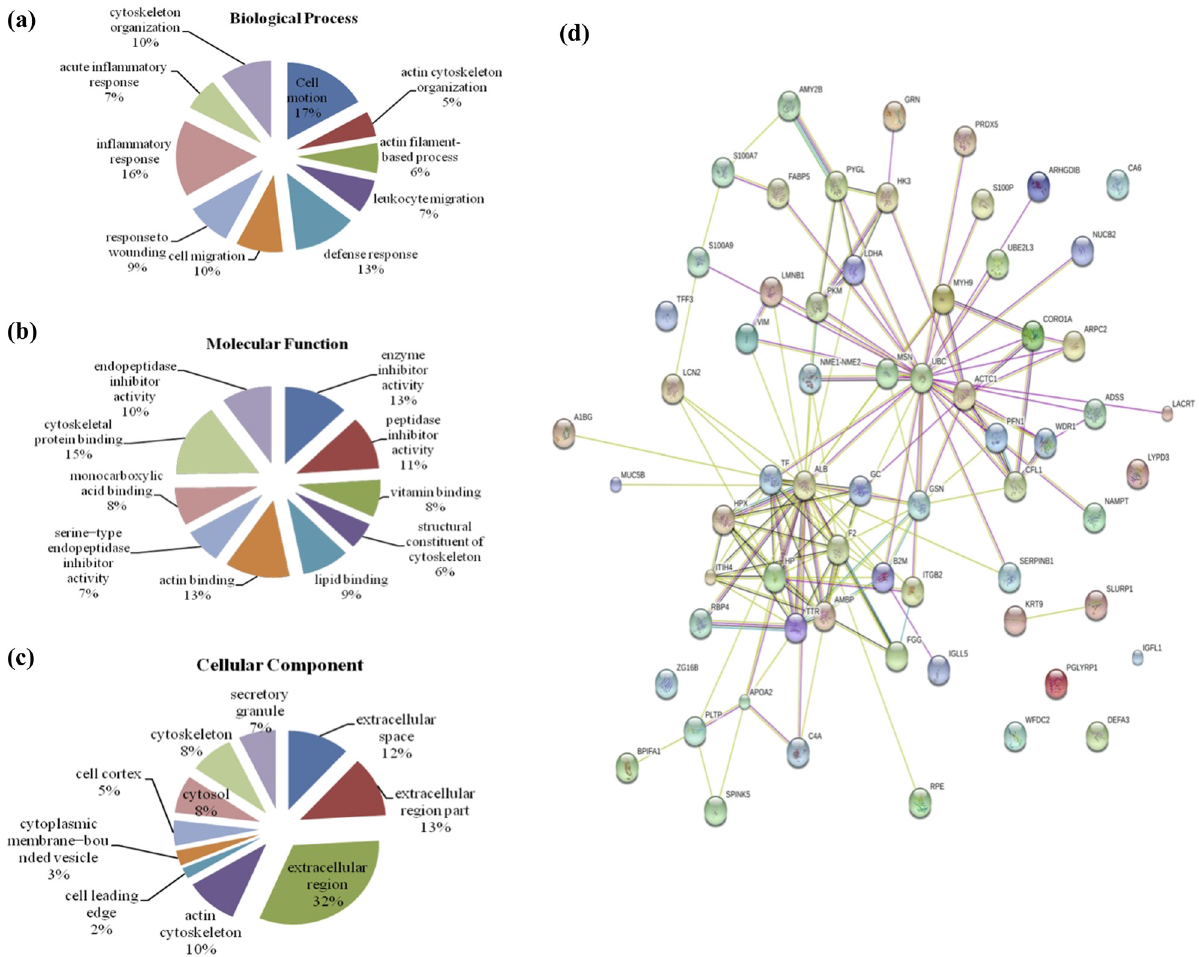
Figure 1: Bioinformatics analysis of di ff erentially expressed proteins. ( a ) Biological process. ( b ) Molecular function. ( c ) Cellular component. ( d ) Network of proteins